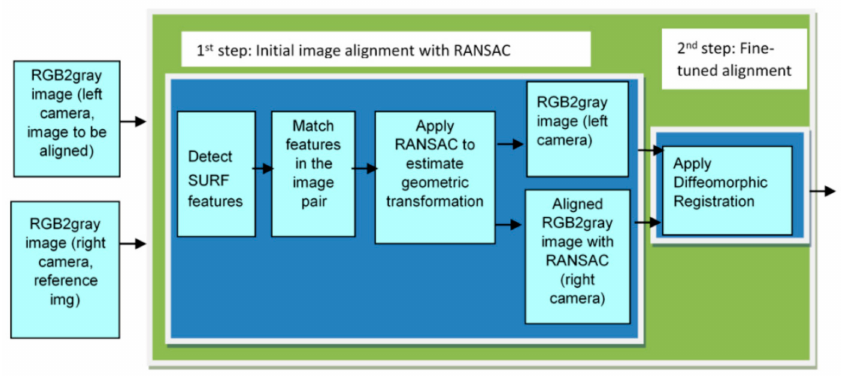
Figure 3. Block diagram of the two-step image registration technique [3].